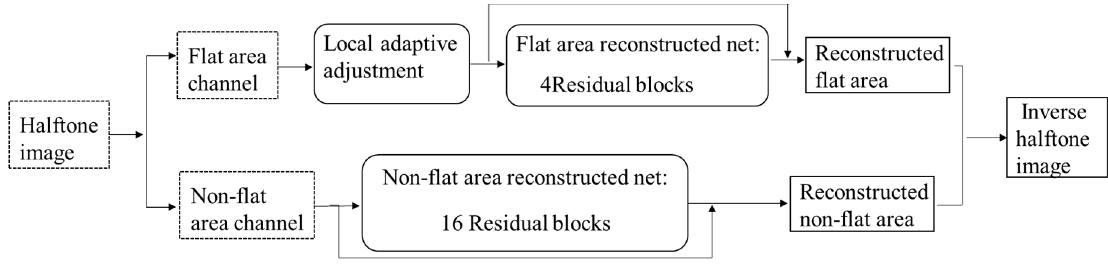
Figure 9. The network architecture in reference [23].